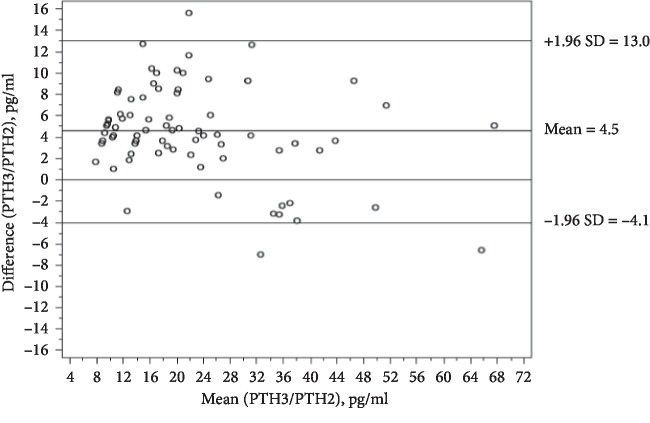
Bland–Altman plot analysing the agreement between the two PTH methods.